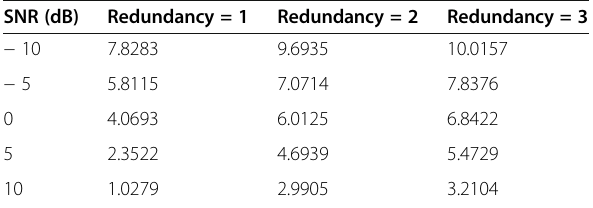
Table 3 Increment of SNR in the white noise environment with different dictionary redundancy (dB)